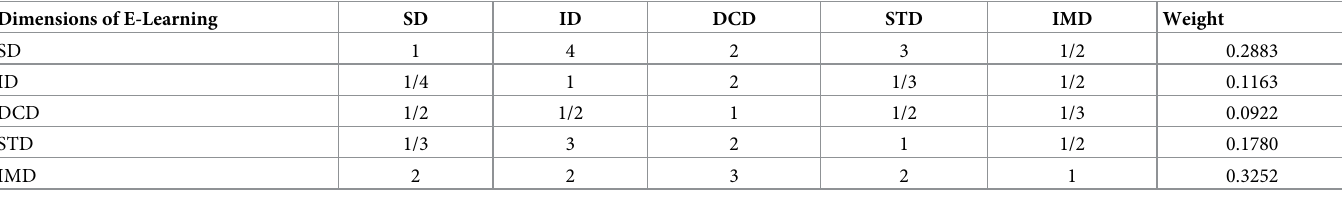
Table 6. A pairwise comparison of E-Learning dimensions by DM4 using AHP-GDM. Dimensions of E-Learning